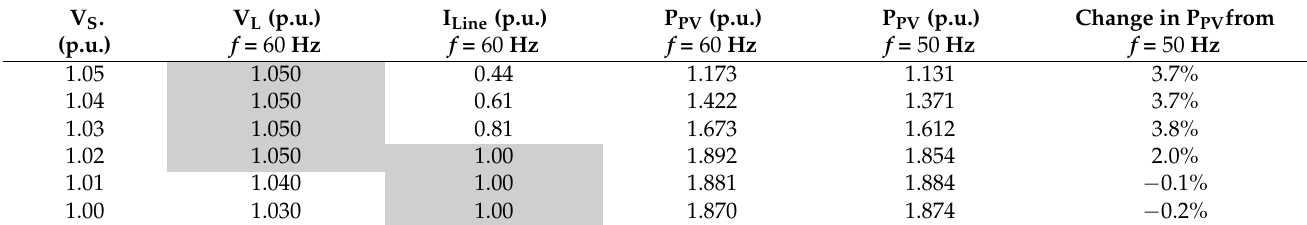
Table 9. Effect of system frequency on maximum PV penetration limit for the UGCL.